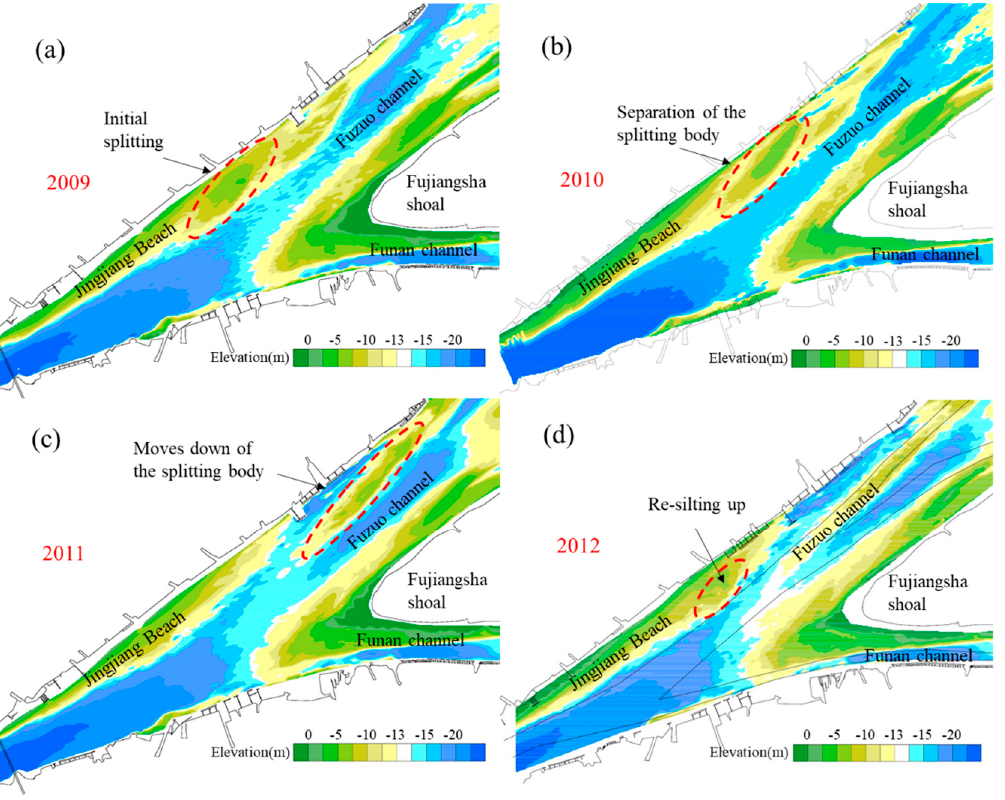
Figure 3. Evolution features of Jingjiang Beach: ( a ) Initial splitting stage; ( b ) splitting completion stage; ( c ) splitting body downward movement stage; ( d ) re-silting up stage. Table 2. Jinjiang Beach splitting statistics since 1966.